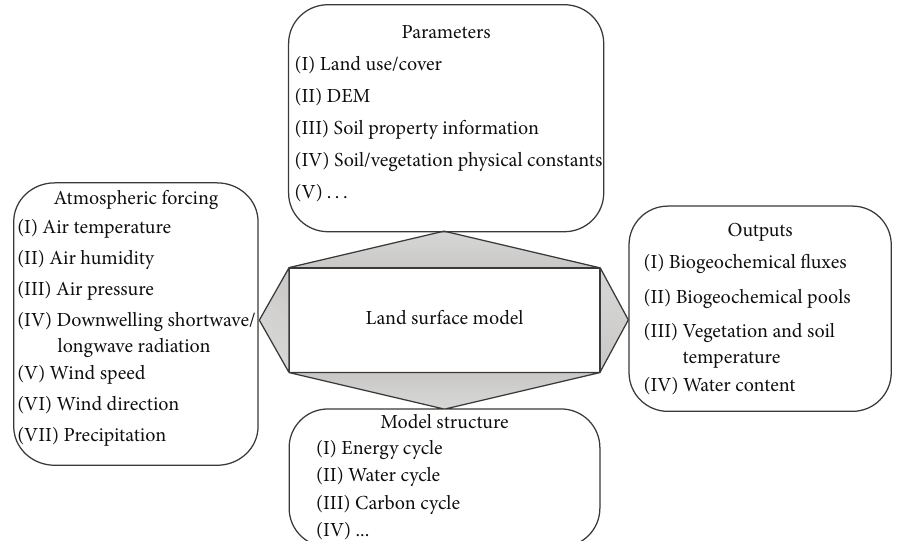
Figure 1: General components of a typical land surface model.